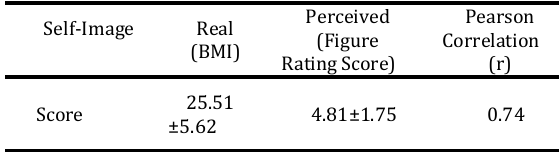
Table 3 Relation between Perception and